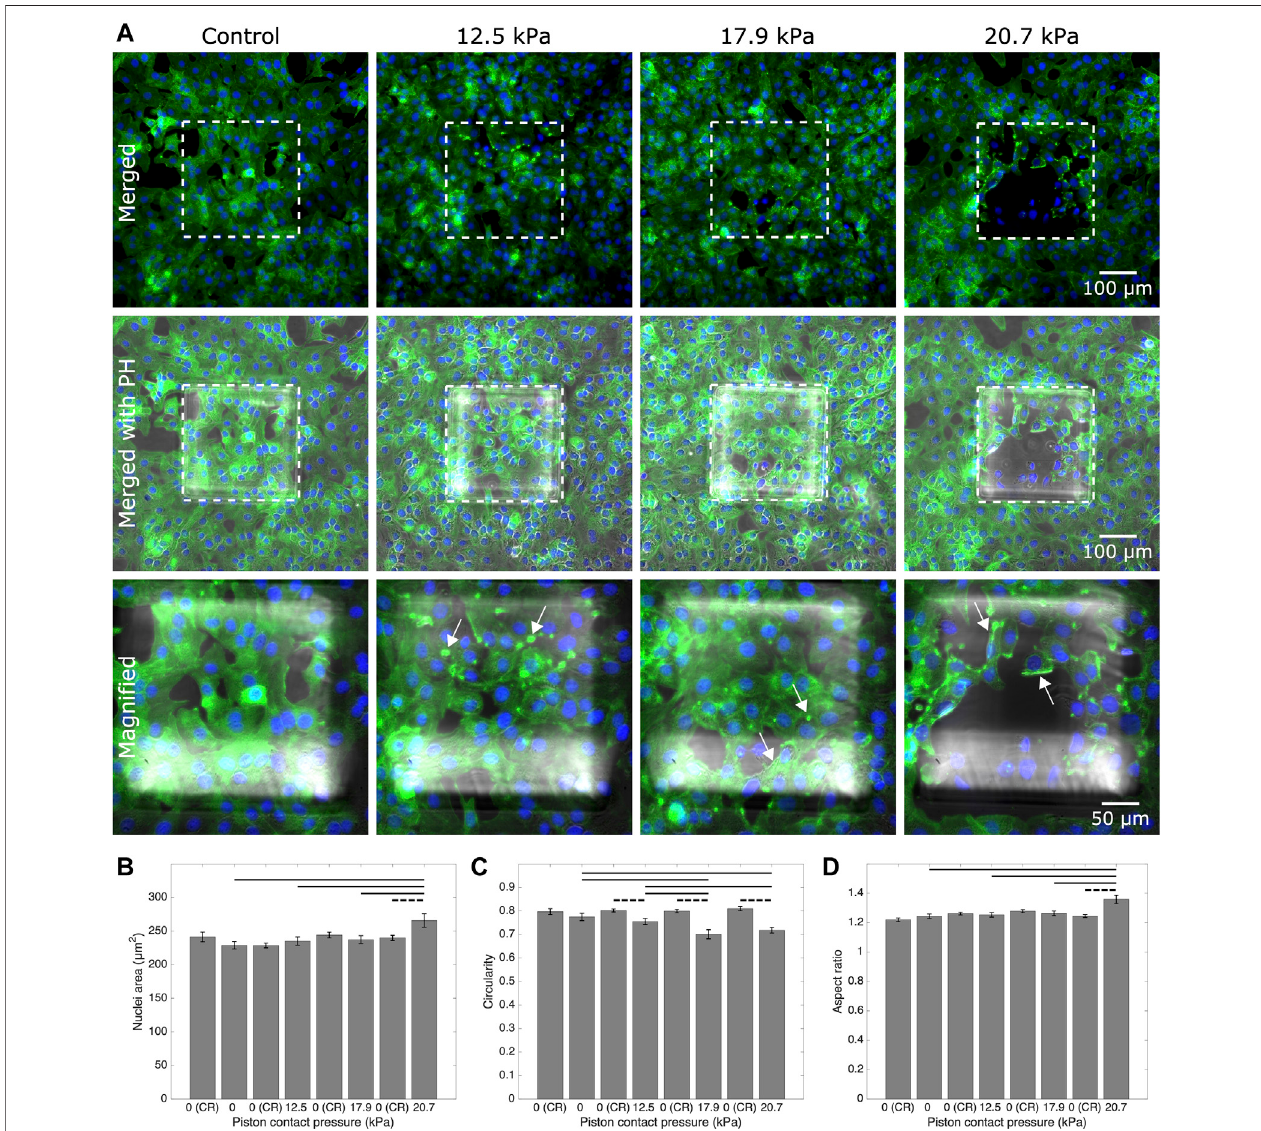
FIGURE 8 | Representative fl uorescent microscopy images and analysis for actin and nuclei of cancer cells which experienced 1-h-long cyclic compression in the micro-piston device. (A) Control and compressed cell groups stained for actin (green) and nuclei (blue). Dashed areas are under the micro-piston, while the surrounding isthecontrolregion(CR).Merged: mergedformofthephalloidin(stainforactin)andHoechst(stainfornuclei)epi- fl uorescenceimages;merged withPH:mergedformof the epi- fl uorescence images with the corresponding phase-contrast (PH) image; magni fi ed: two hundred-fold magni fi cation images of the region under micro-piston indicated with the dashed area in the row of “ merged with PH. ” Representative arrows (white) show the distinct actin deformation by the increased fl uorescence signals at the edges of the cells in the compressed groups under the micro-piston. Nuclear deformation in control (noncompressed) cells under the static micro-pistonandcontrolregion(CR)aroundthemicro-pistonvs.incompressedcellsunderthemicro-pistonmeasuredforarea (B) ,circularity (C), andaspectratio (D) of the cell nuclei (mean ± s.e.m. n (cid:2) 73, 63, 185, 71, 161, 74, 163, 92 cell nuclei). Dashed horizontal bars show signi fi cant differences between the control region (CR) groupandcompressedgroupundermicro-piston,inthesame deviceasper eachpair.Continuoushorizontalbarsshowthecomparison pairsamongthegroupsunder the